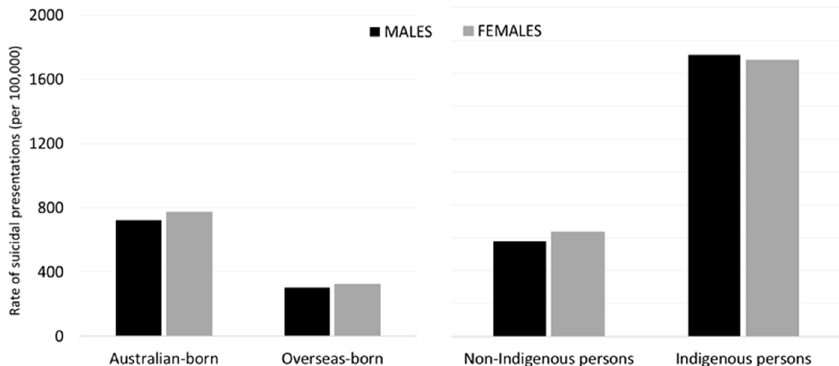
Figure 2. Rates of suicidal presentations by ethnicity groups, 2009–2018.